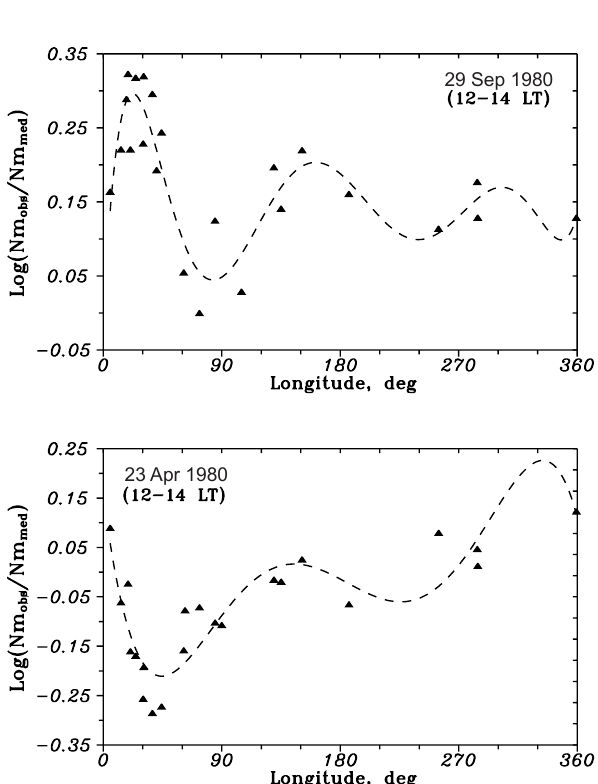
Fig. 5. Longitudinal variation for the amplitude of strong quiet-time NmF2 deviations observed in the European sector on 29 Sep 1980 (positive deviation) and 23 Apr 1980 (negative deviation). Northern hemisphere ionosonde stations located in the 50 ± 5 ◦ latitudinal cor- ridor are used in the analysis. The dashed line represents a polyno- mial (the 5 th order) least squares approximation. Note that maximal and minimal deviations are located in a narrow longitudinal